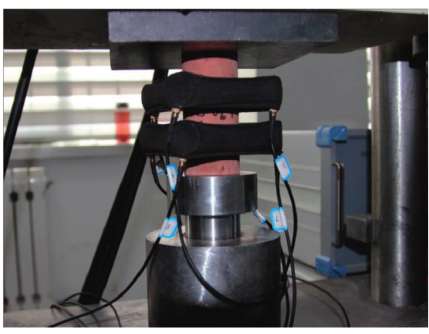
Figure 3: AE device.